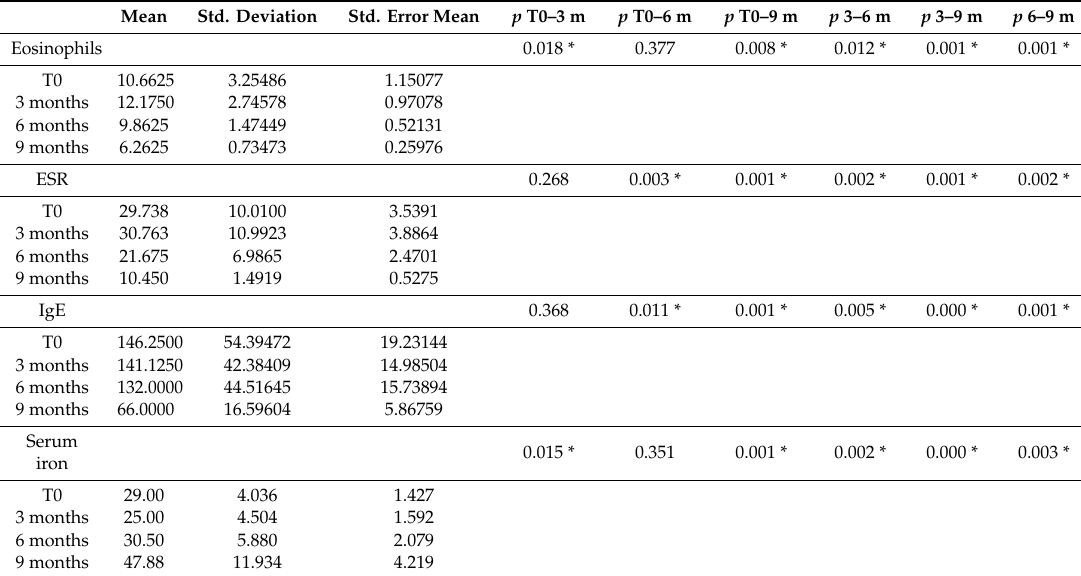
Table 7. Correlation of disease progression in third subgroup, which did not receive any treatment in the first 3